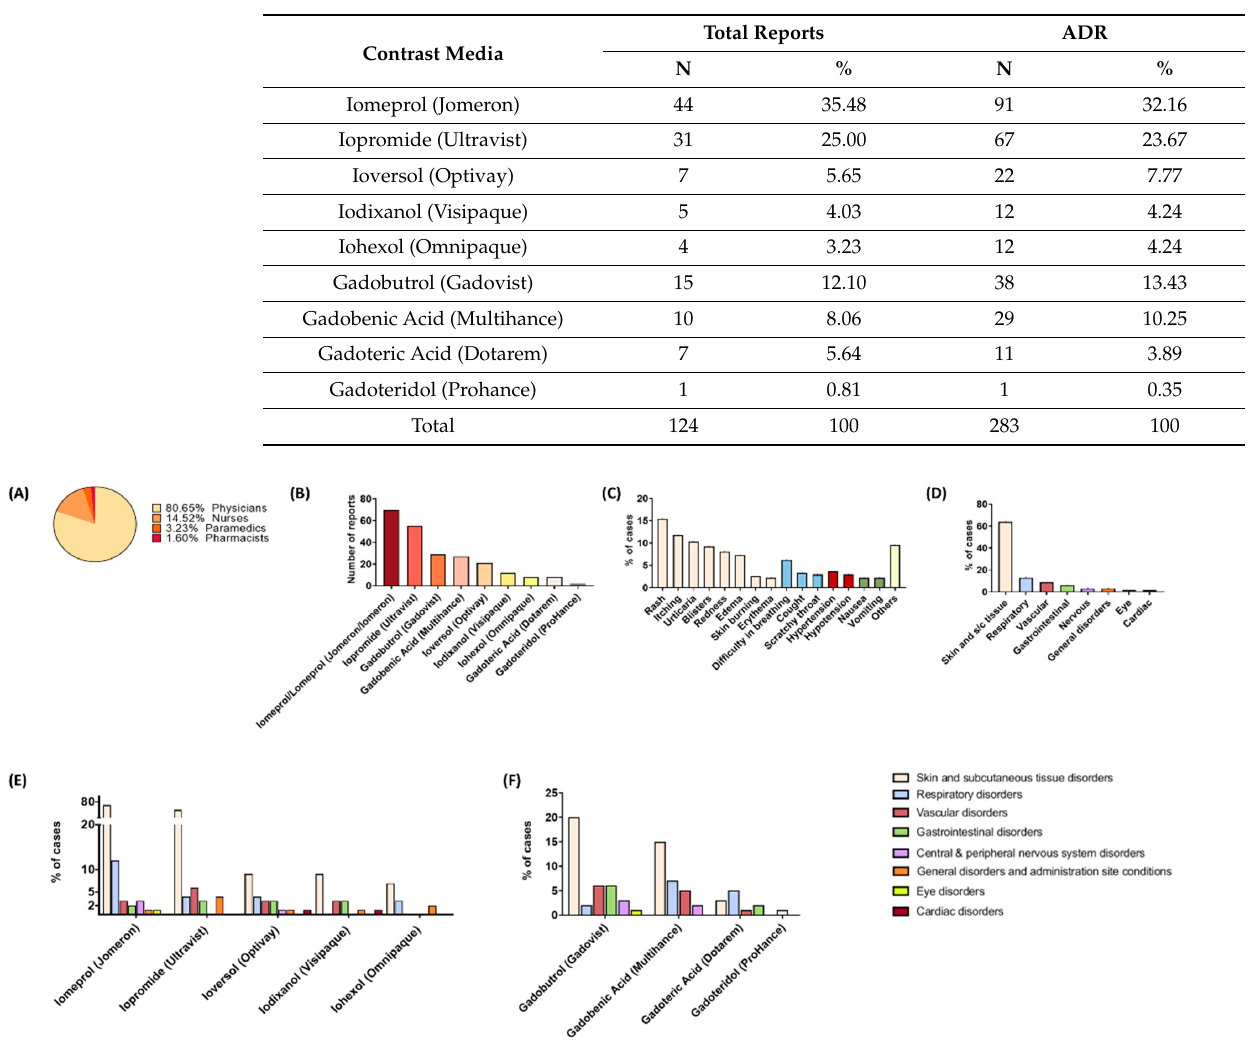
Figure 3. ( A ) Percentage participation in reporting of the contrast media adverse drug reactions; ( B ) Number of reports for each of iodine- and gadolinium-based contrast media; ( C ) Percentage participation of specific adverse drug reactions in the group of reports; ( D ) Adverse drug reactions divided into organ-specific sections; ( E ) Detailed participation of each side effect in the toxicity of each iodine-based contrast medium; and ( F ) Detailed participation of each side effect in the toxicity of each gadolinium-based contrast